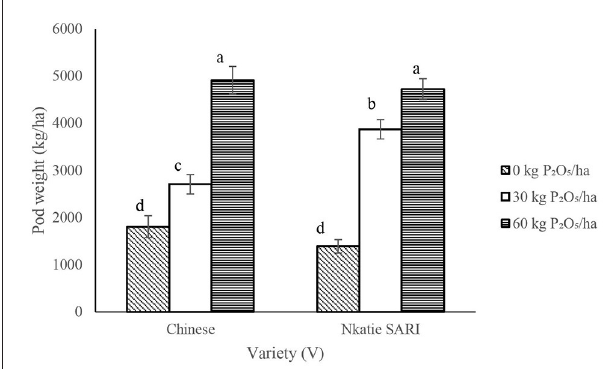
FIGURE 7 | Interactive effect of P-rate (PR) and inoculant rate (IR) on pod weight of groundnut grown in Haplic Lixisols of northern Ghana. Bars with different letters (in horizontal direction) show significantly different means. Error bars represent standard error of